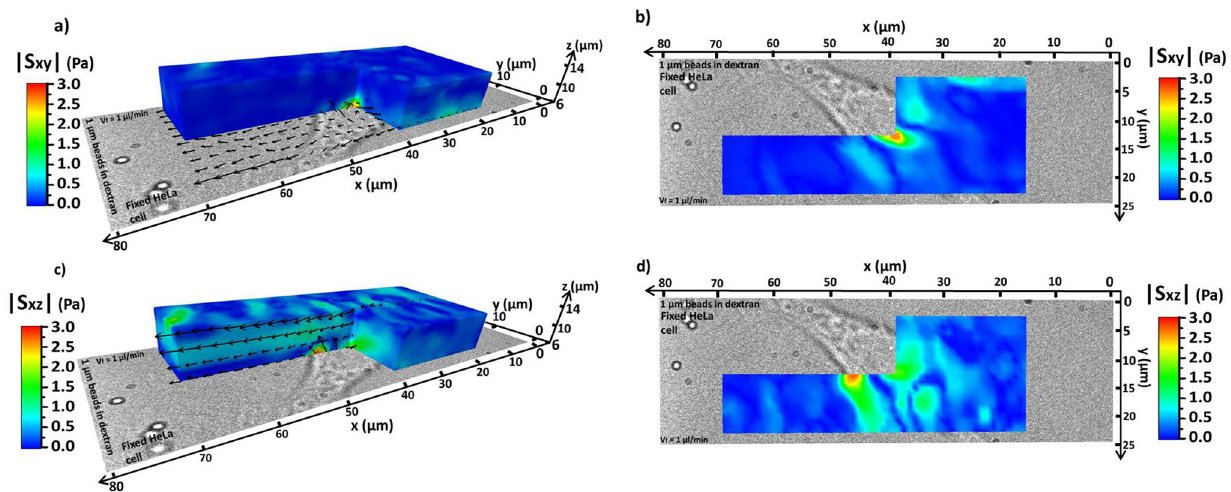
Figure 4. 3D maps of the absolute values of the shear stress among different planes generated by the fluid of 1 µm beads in dextran flowing around the used fixed HeLa cell. The fluid flows from right to left along the x axis. The images in ( a ) and ( c ) show the side view, while those in ( b ) and ( d ) the bottom view. S xy is shown in ( a ) and ( b ) S xz in ( c ) and ( d